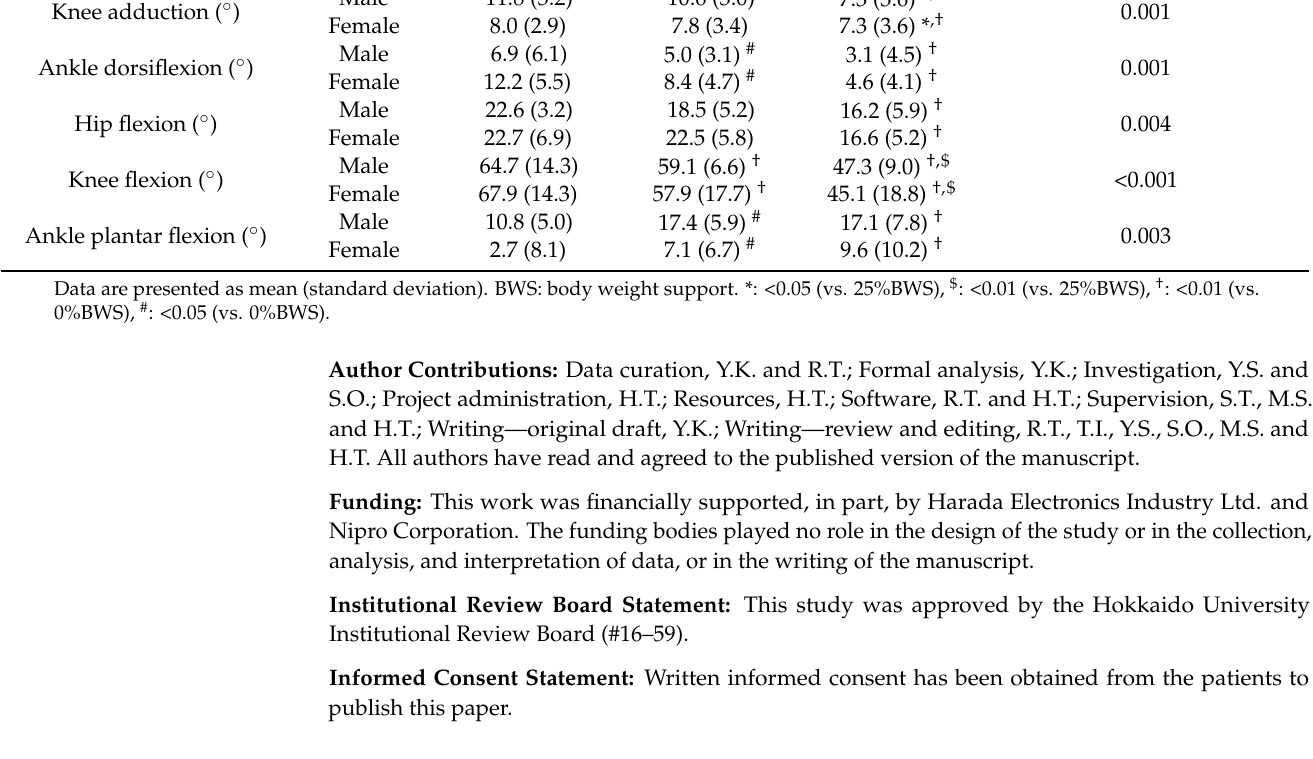
Table 1. Peak angles of the hip, knee, and ankle joints under 0%, 25% and 50%BWS conditions for male and female participants.